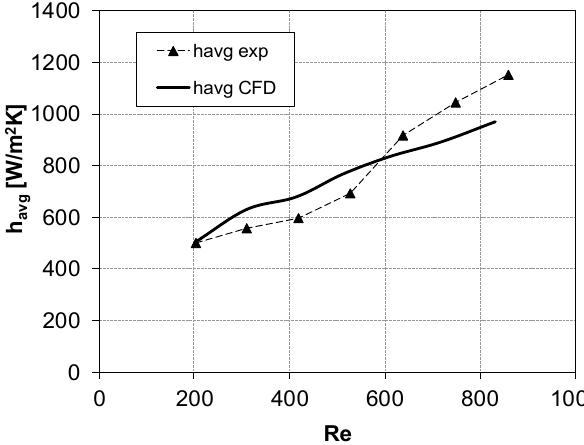
Figure 8. h avg vs Re for θ = 60°, α = 30° (configuration 1). Symbols denote the experimental results, while CFD results are represented by the thick solid line.